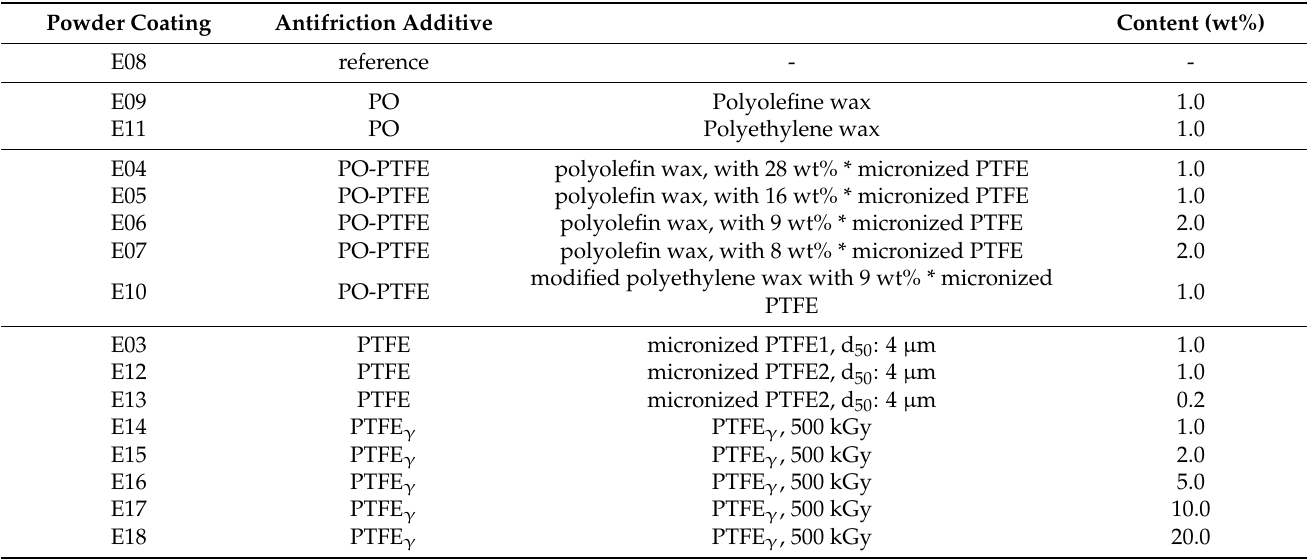
Table 1. Antifriction powder coating basic formulations/screening of solid